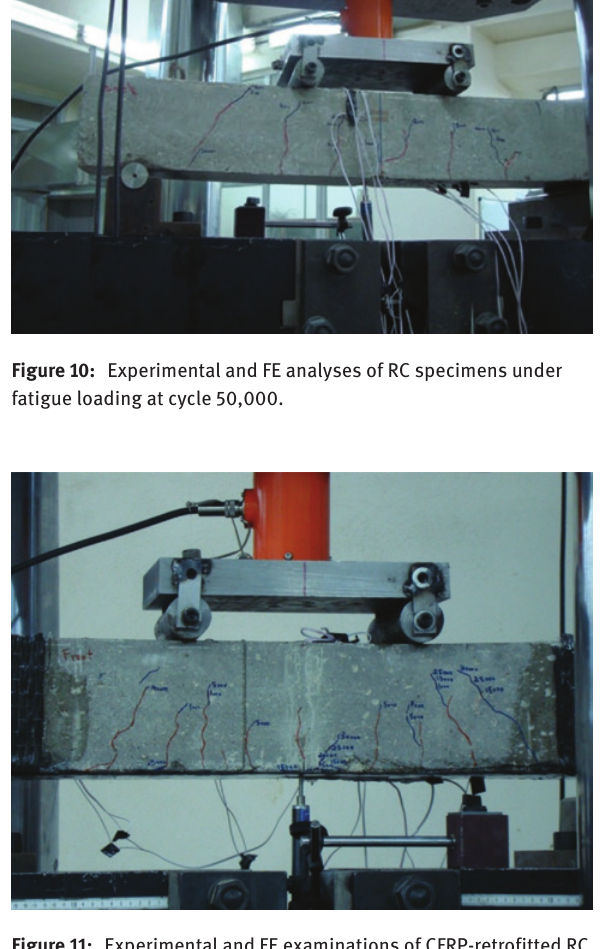
Figure 11: Experimental and FE examinations of CFRP-retrofitted RC specimens under fatigue loading at cycle 50,000.